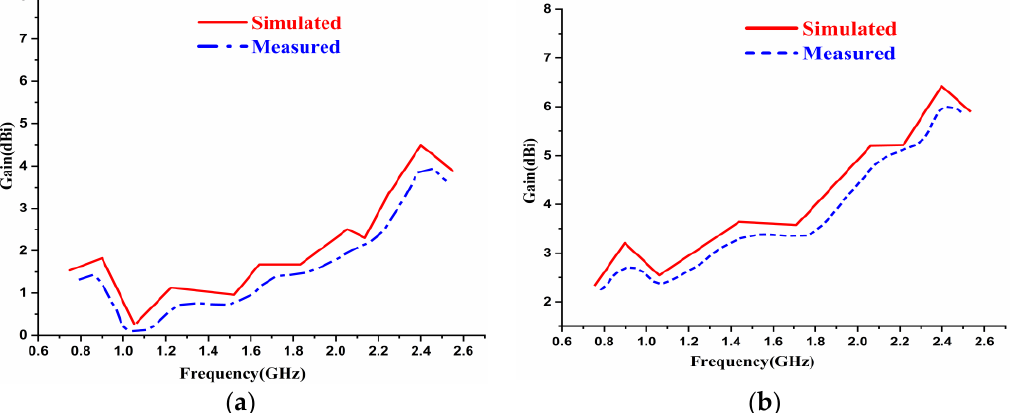
Figure 20. Gain versus Frequency plot of the antenna ( a ) without AMC Backing ( b ) with AMC Back- ing.